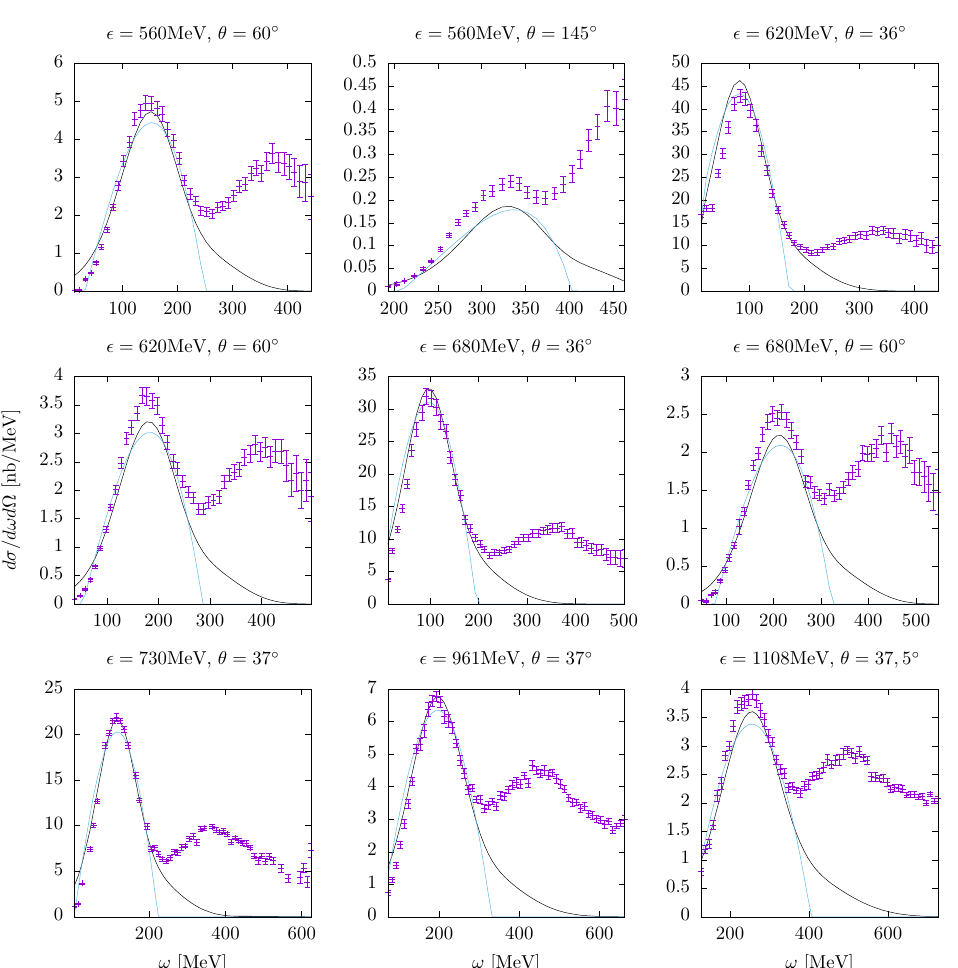
Figure 9. Quasielastic ( e , e (cid:48) ) cross section of 12 C as a function of ω for several values of the electron energy, (cid:101) , and scattering angles θ , computed with the present SuSAM* model (black lines) compared to the RFG with effective mass (blue lines). Experimental data (purple lines) are from refs.